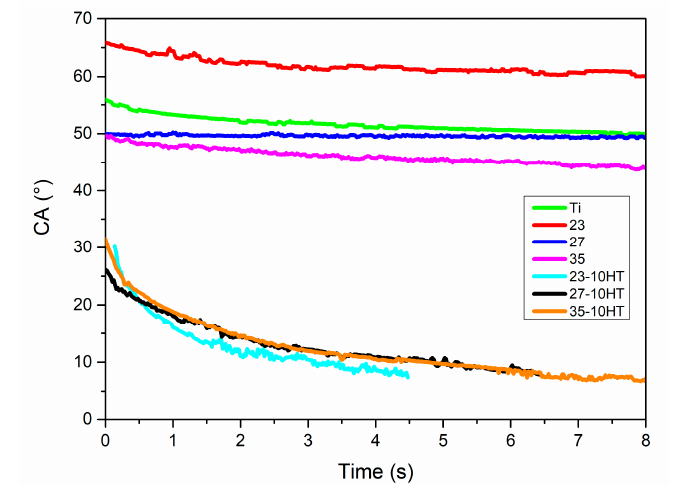
Figure 15. A glycerol contact angle relation for 23-10HT, 27-10HT, 35-10HT, Ti23Mo, Ti27Mo, and Ti35Mo samples in a time